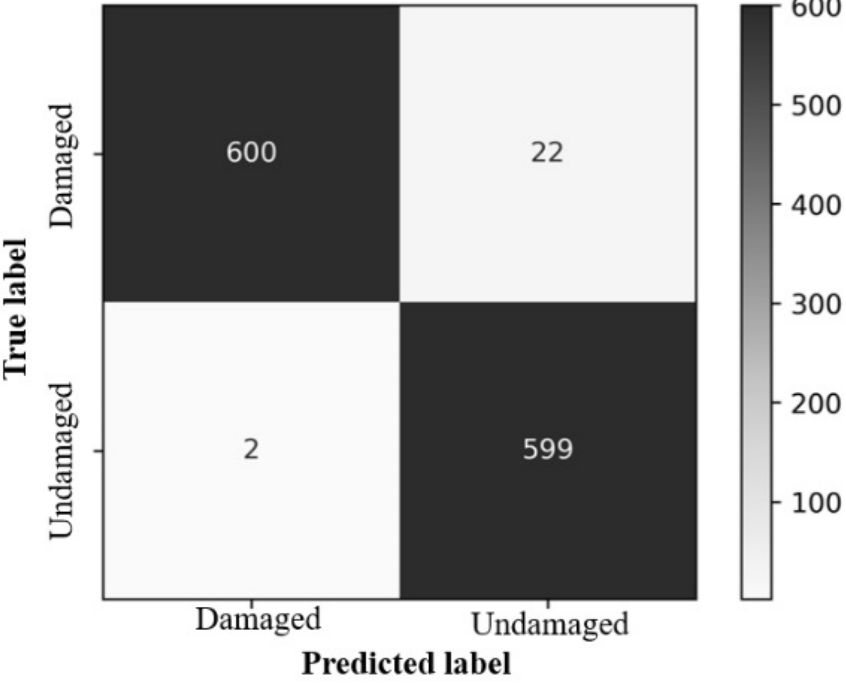
Figure 11. Confusion matrix of the damaged rice kernels .